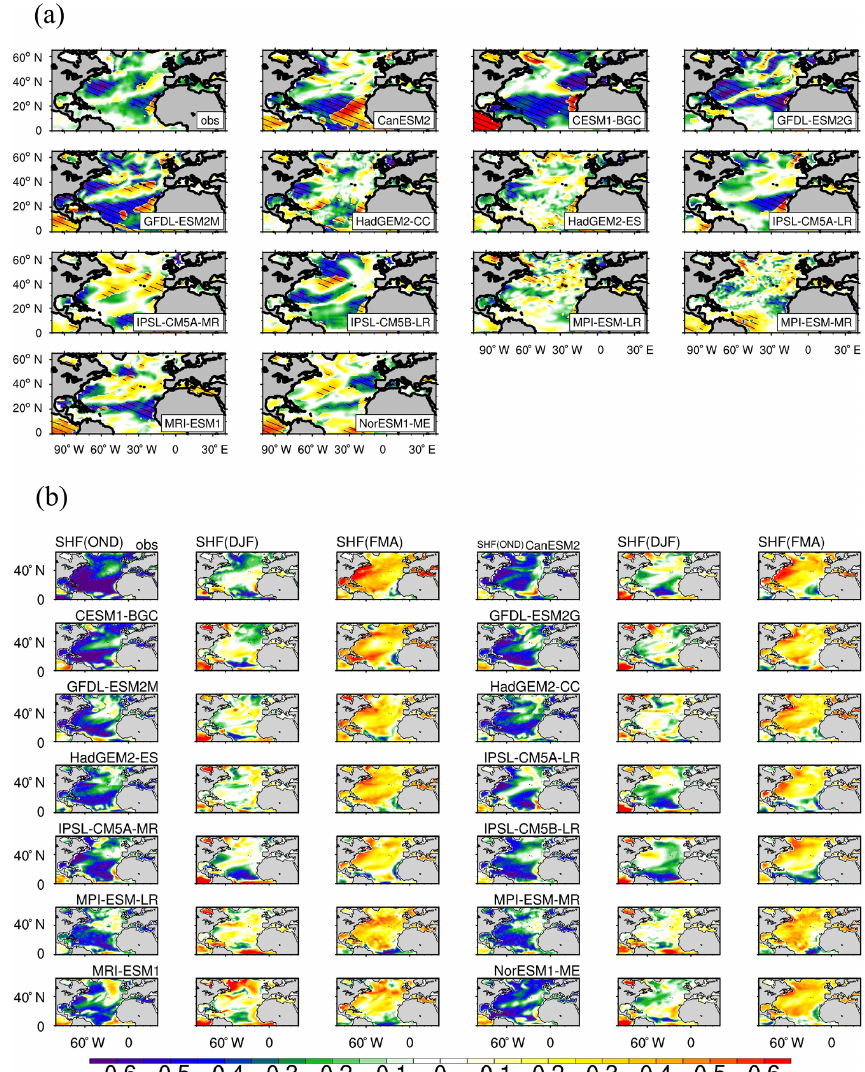
Figure 8. (a) Same as Fig. 4 but for the winter-average SST anomalies against the NAO-driven SHF anomalies. (b) The standardized lagged (lead) covariance between monthly SHF anomalies from October to December and from February to April with the SST anomalies from December to January. OND refers to the SHF from October to December, and FMA refers to the SHF from February to